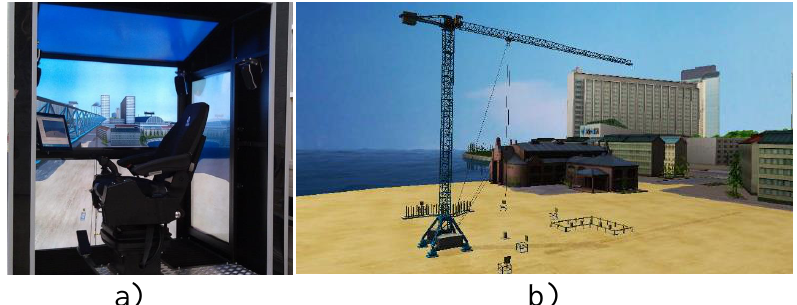
Figure 4. ( a ) Cabin of the multibody dynamics simulator and ( b ) model of a Liebherr 112EC-B8 tower crane.